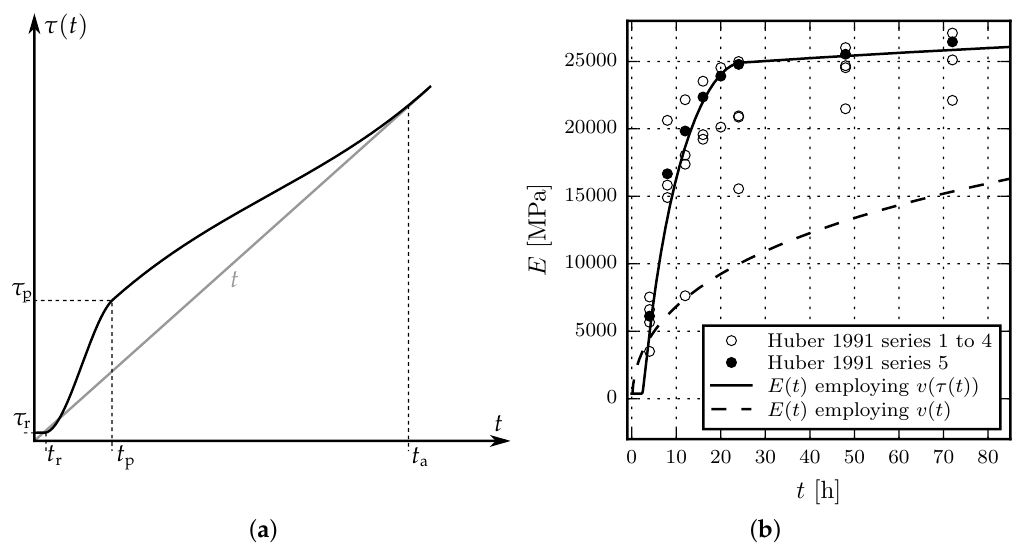
Figure 1. ( a ) Illustration of the time transformation function τ ( t ) (black curve) versus time t (straight gray line); ( b ) Evolution of the Young’s modulus E ( t ) , based on v ( t ) and v ( τ ( t )) , and comparison with experimental data by Huber